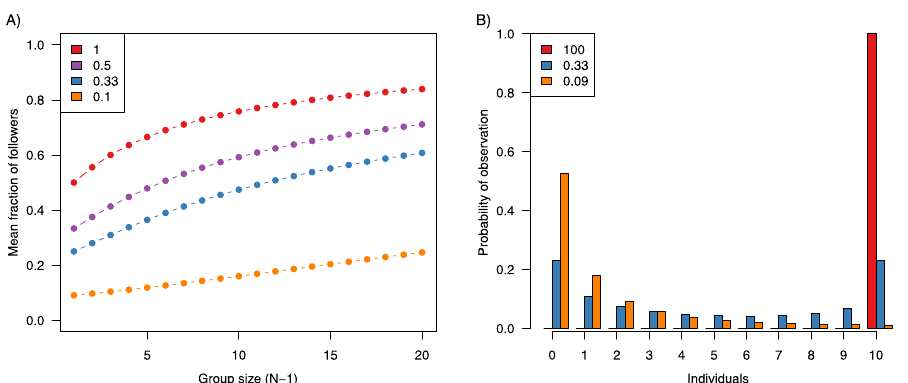
Fig. 8 Results from the analytical model. A Relationship between the mean fraction of followers (number of followers/( N – 1)) and group size ( N – 1) for different values of P J / P C0 . B Probability of obtaining i followers (individuals) considering a group with ten potential followers ( N – 1 = 10). In both fi gures, colours indicate the ratio P J / P